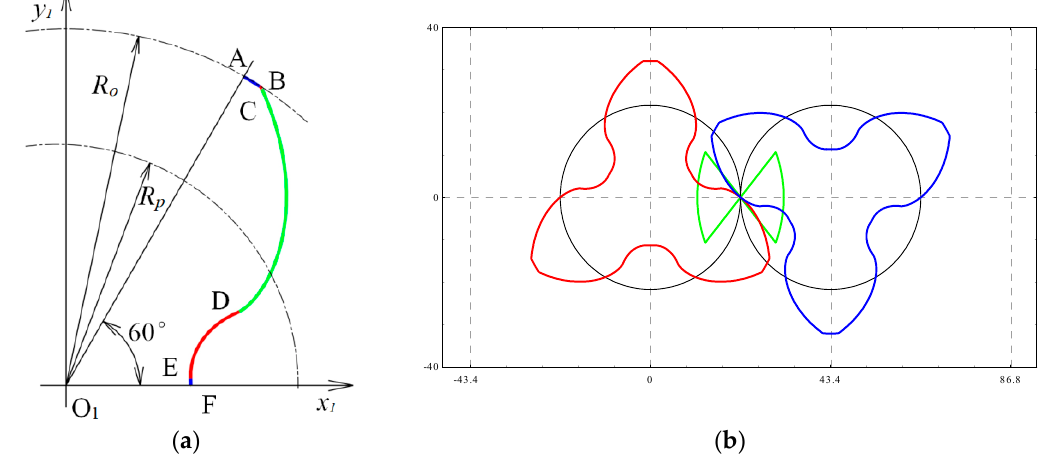
Figure 1. Profile of the Roots pump: ( a ) composing curves; and ( b ) profile and engage line.